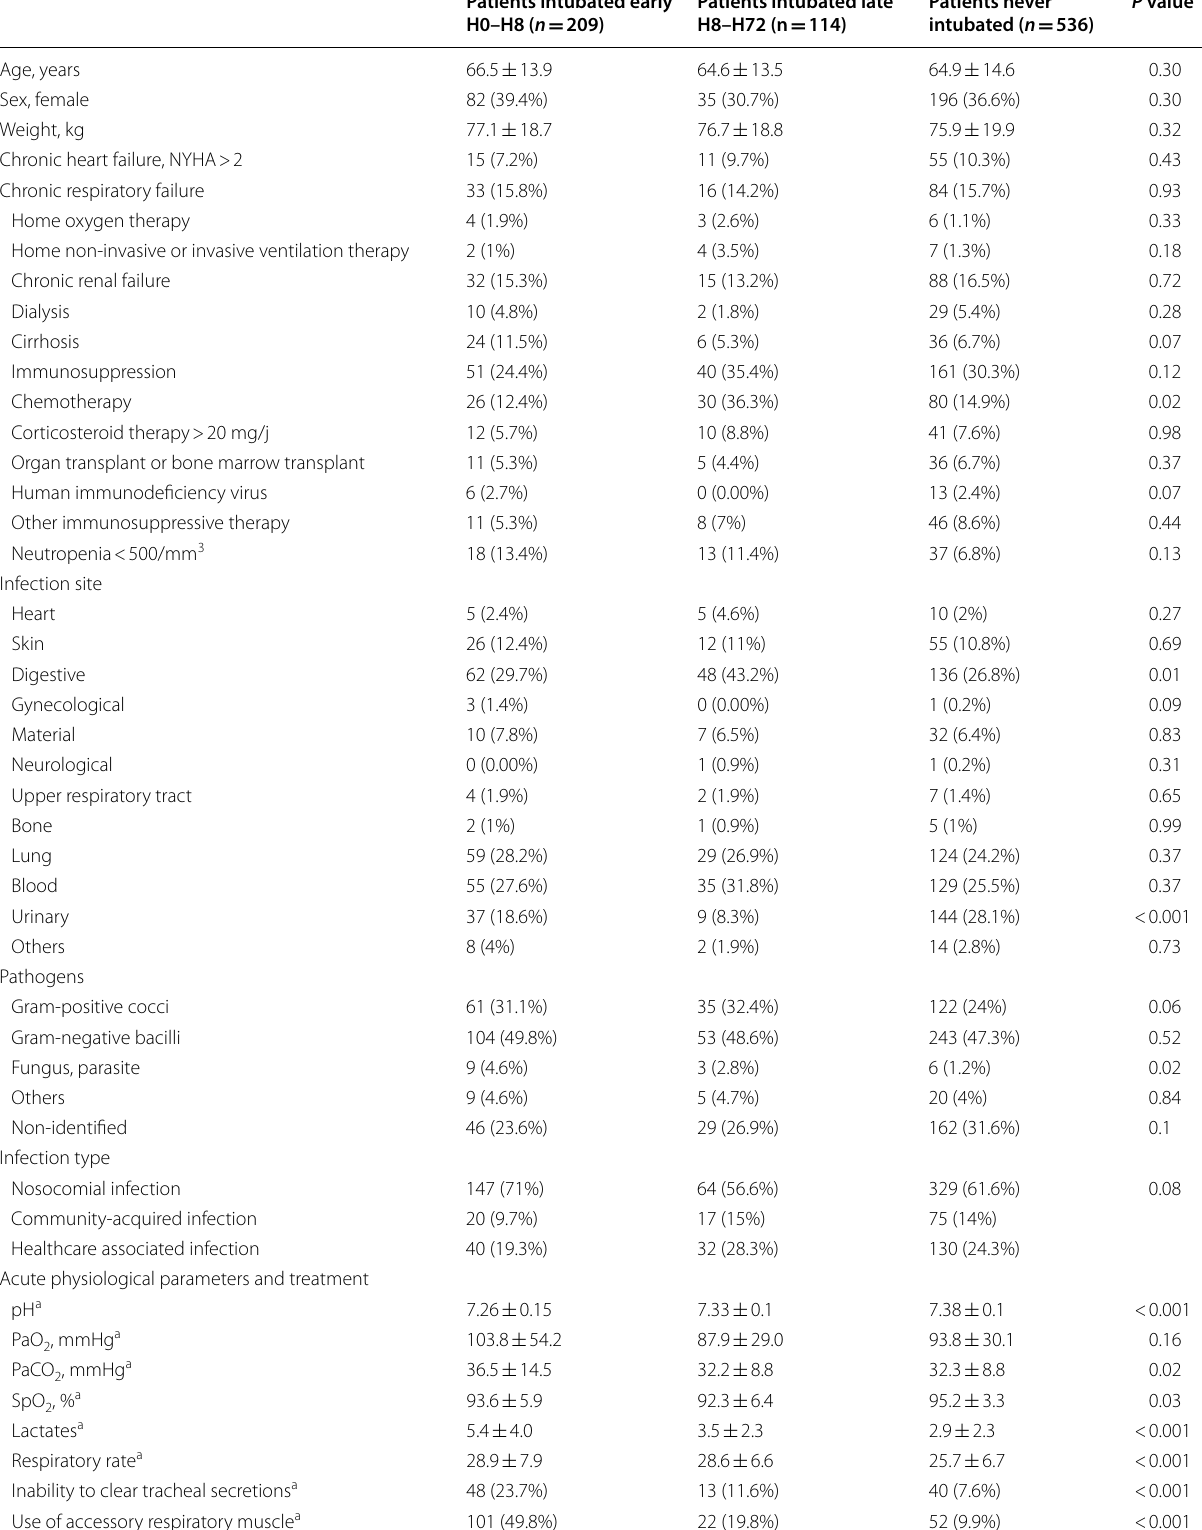
Table 1 Patient’s demographic data and outcome according intubation during the ICU stay